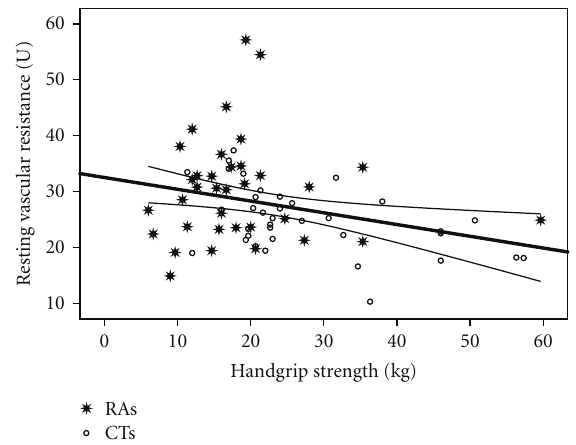
Figure 4: Relationship between handgrip strength and resting vascular resistance. r = − 0 . 3; P = 0 . 009.